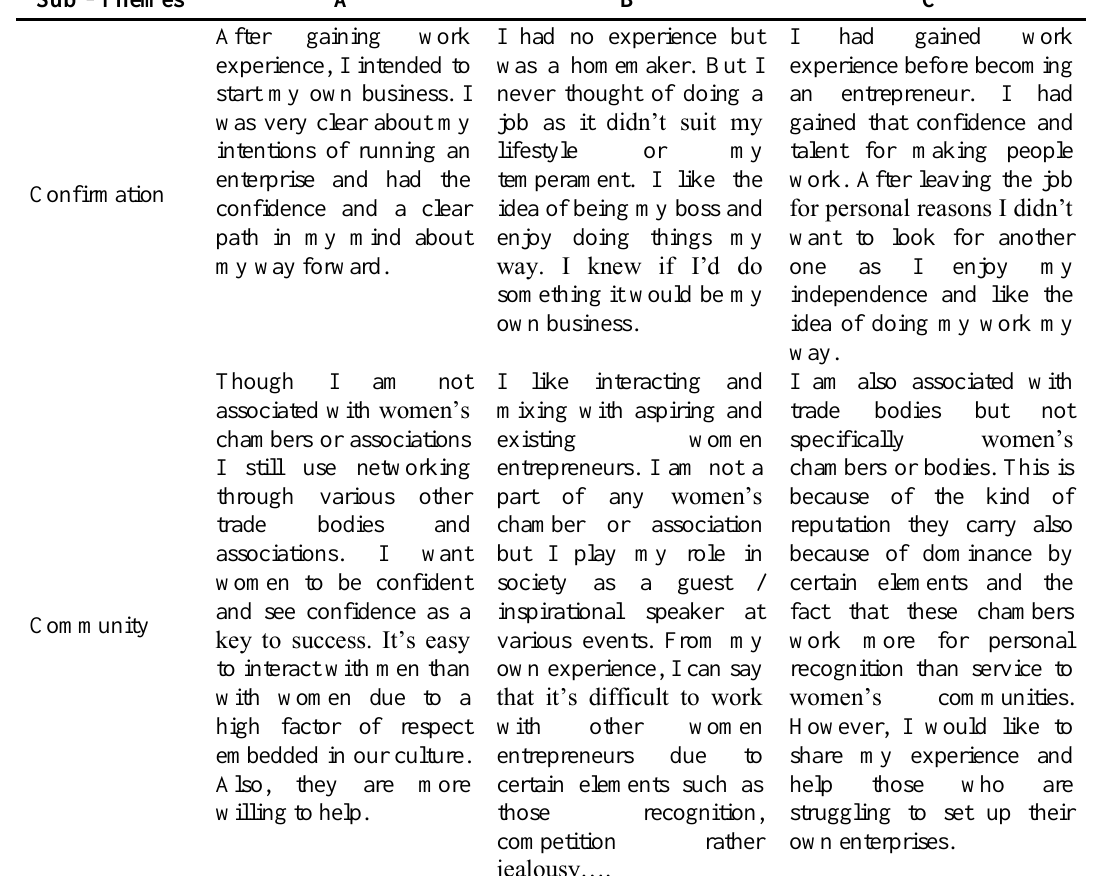
Table.6. Women’s Entrepreneurial Self as